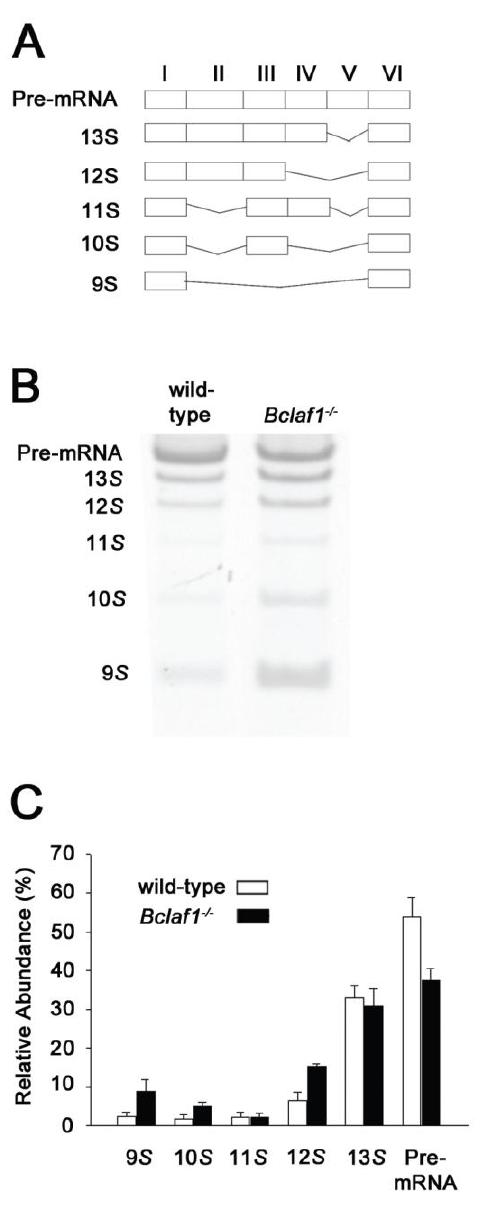
FIGURE 2. Bclaf1 deficiency impacts alternative splicing profiles. (A) Diagram of E1A pre-mRNA showing alternative splicing events that generate 13 S , 12 S , 11 S , 10 S , and 9 S mRNAs. (B) Representative photomicrograph of TBE-PAGE gel showing spliced transcripts generated from embryonic fibroblasts (wild-type or Bclaf1 –/– ) transfected with E1A minigene. (C) Relative levels of E1A mRNA species in wild- type (white bars) or Bclaf1 –/– (black bars) embryonic fibroblasts. Error bars represent standard deviation of three independent experiments. Wild-type or Bclaf1 –/– embryonic fibroblasts were transiently transfected with pCMVE1A[67], reverse-transcribed, and amplified by PCR over a range of 9 to 30 cycles. Reactions were electrophoresed in 5% TBE- PAGE gels and amplified reaction products were visualized following staining with Vistra-Green (GE Healthcare). Imaging of reaction products was captured using a PhosphorImager and quantified using ImageQuant software (Molecular Dynamics). The log intensity of reaction products was plotted vs. cycle number, and quantification was performed on reaction products in the linear range of